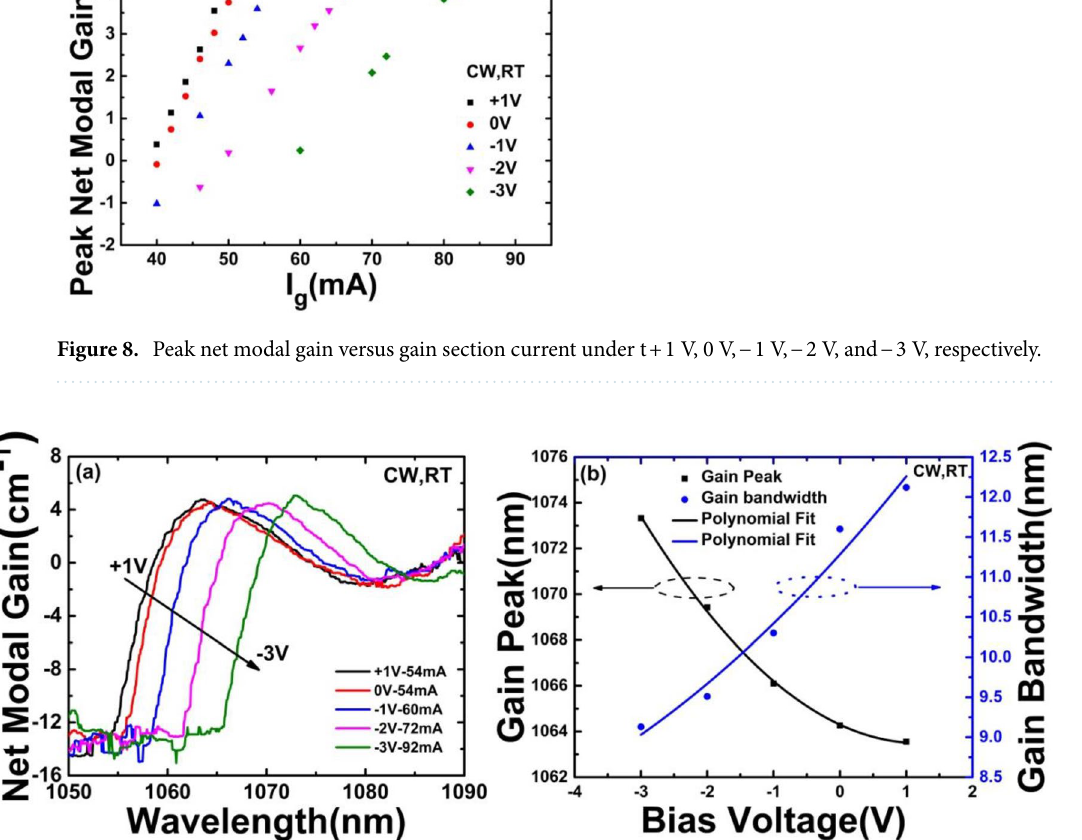
Figure 9. ( a ) V a -dependent threshold gain spectra of the MLL from + 1 to − 3 V. ( b ) Modal gain peak (Black square and polynomial fitting line: y = (1064.3009 ± 0.09679) + (− 1.34671 ± 0.09863)x + (0.56214 ± 0.04245)x 2 , Residual Sum of Squares = 0.05045, R 2 (COD) = 0.99923, Adj.R 2 = 0.99846) and gain bandwidth (blue circle and polynomial fitting line: y = (11.28257 ± 0.17727) + (0.91986 ± 0.18065)x + (0.05643 ± 0.07774)x 2 , Residual Sum of Squares = 0.16921, R 2 (COD) = 0.97484, Adj. R 2 = 0.94969) of the MLL versus bias voltage,